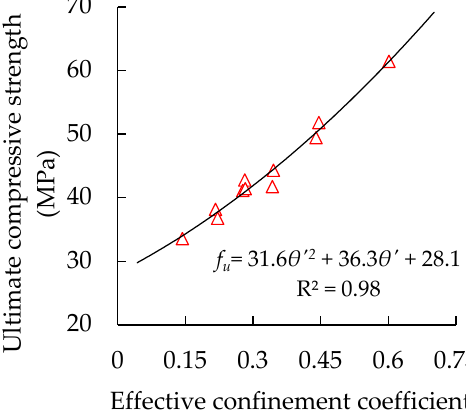
Figure 9. Relationship between specimens’ ultimate compressive strength and confinement factors.